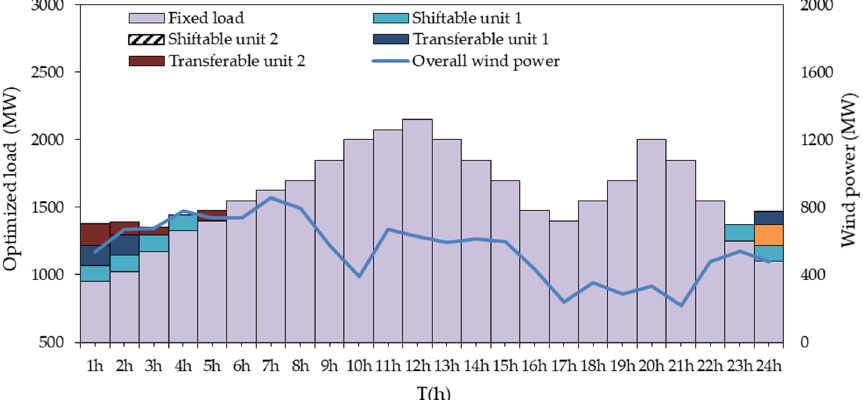
Figure 7. Optimized load curve of VPP in Case 4.